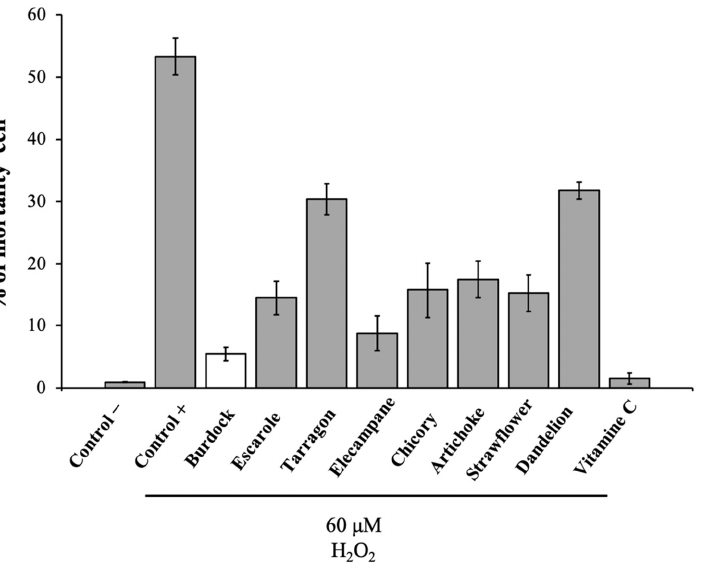
Figure 1. Protective effect of eight bitter Asteraceae fraction (100 µg·mL −1 ) against artificial oxidative stress induced by H 2 O 2 on L6 myocytes compared to Vitamin C (10 µg·mL −1 ) as positive control.